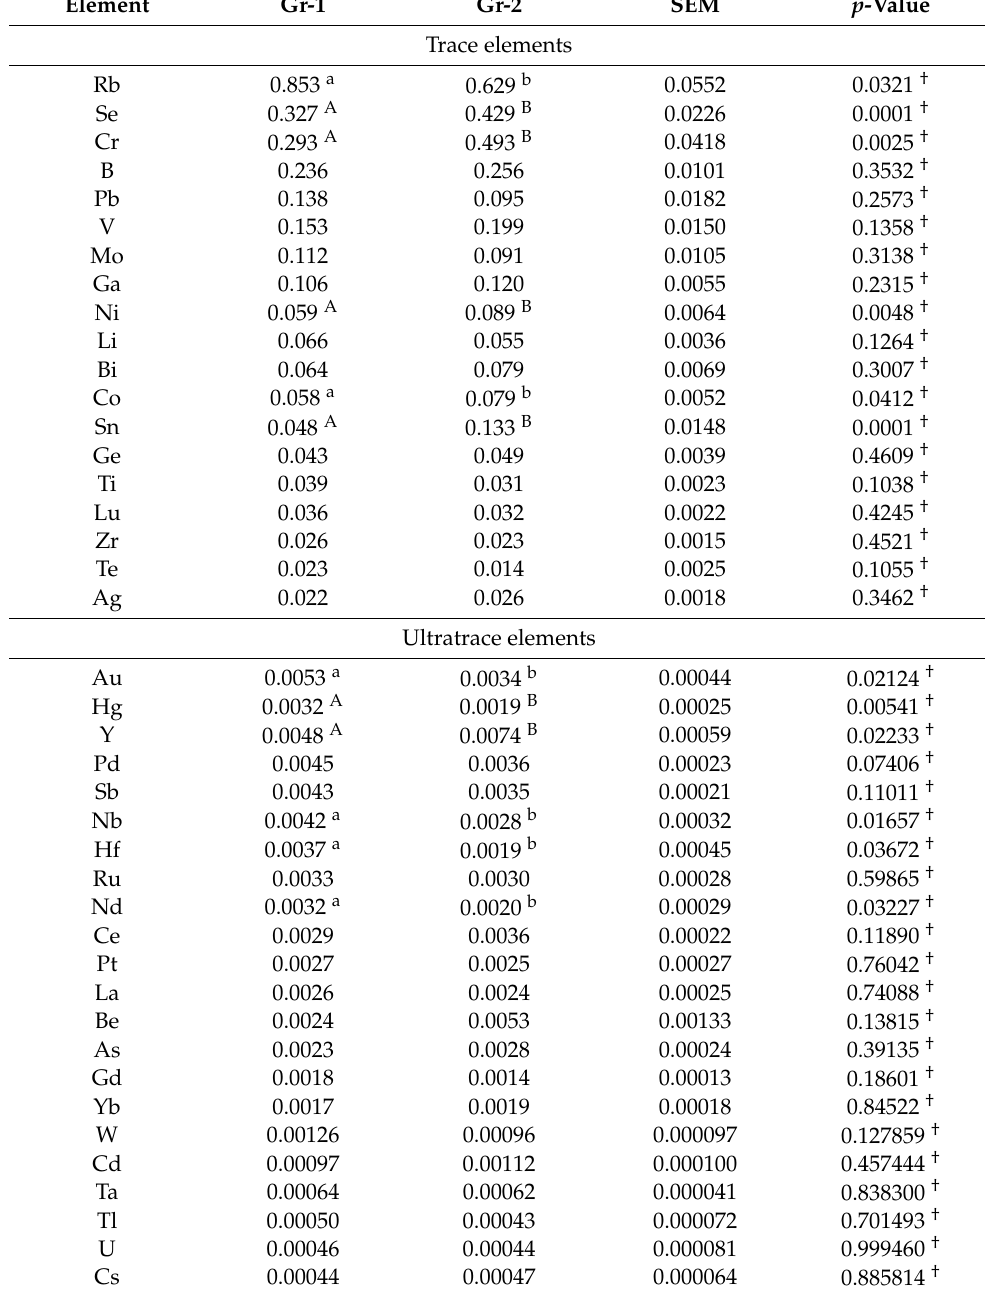
Table 8. The content of trace and ultratrace elements in the egg yolk